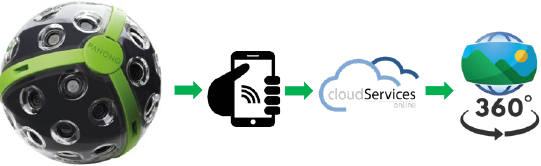
Figure 1. The Panono 360  with a schematic representation of the workflow used to create